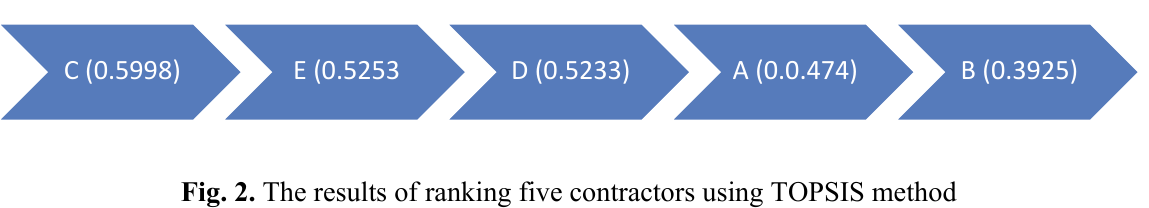
Fig. 2. The results of ranking five contractors using TOPSIS